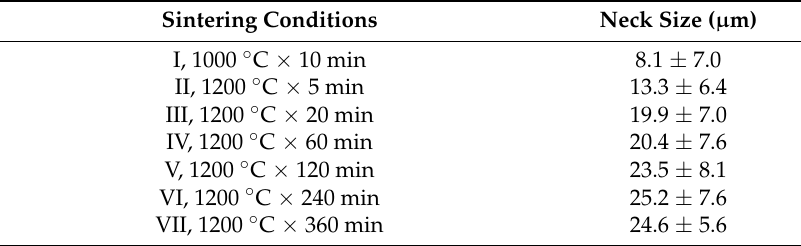
Table 4. Average neck size of sintering joints in different CT samples.